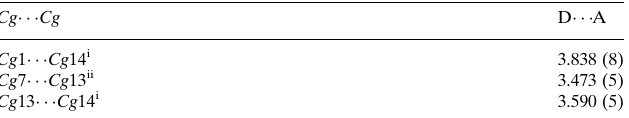
Table 2 (cid:3) - (cid:3) hydrogen-bond geometry (A˚